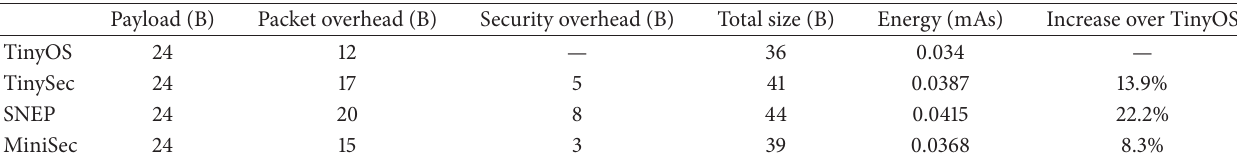
Table 5: Minisec performances compared to other